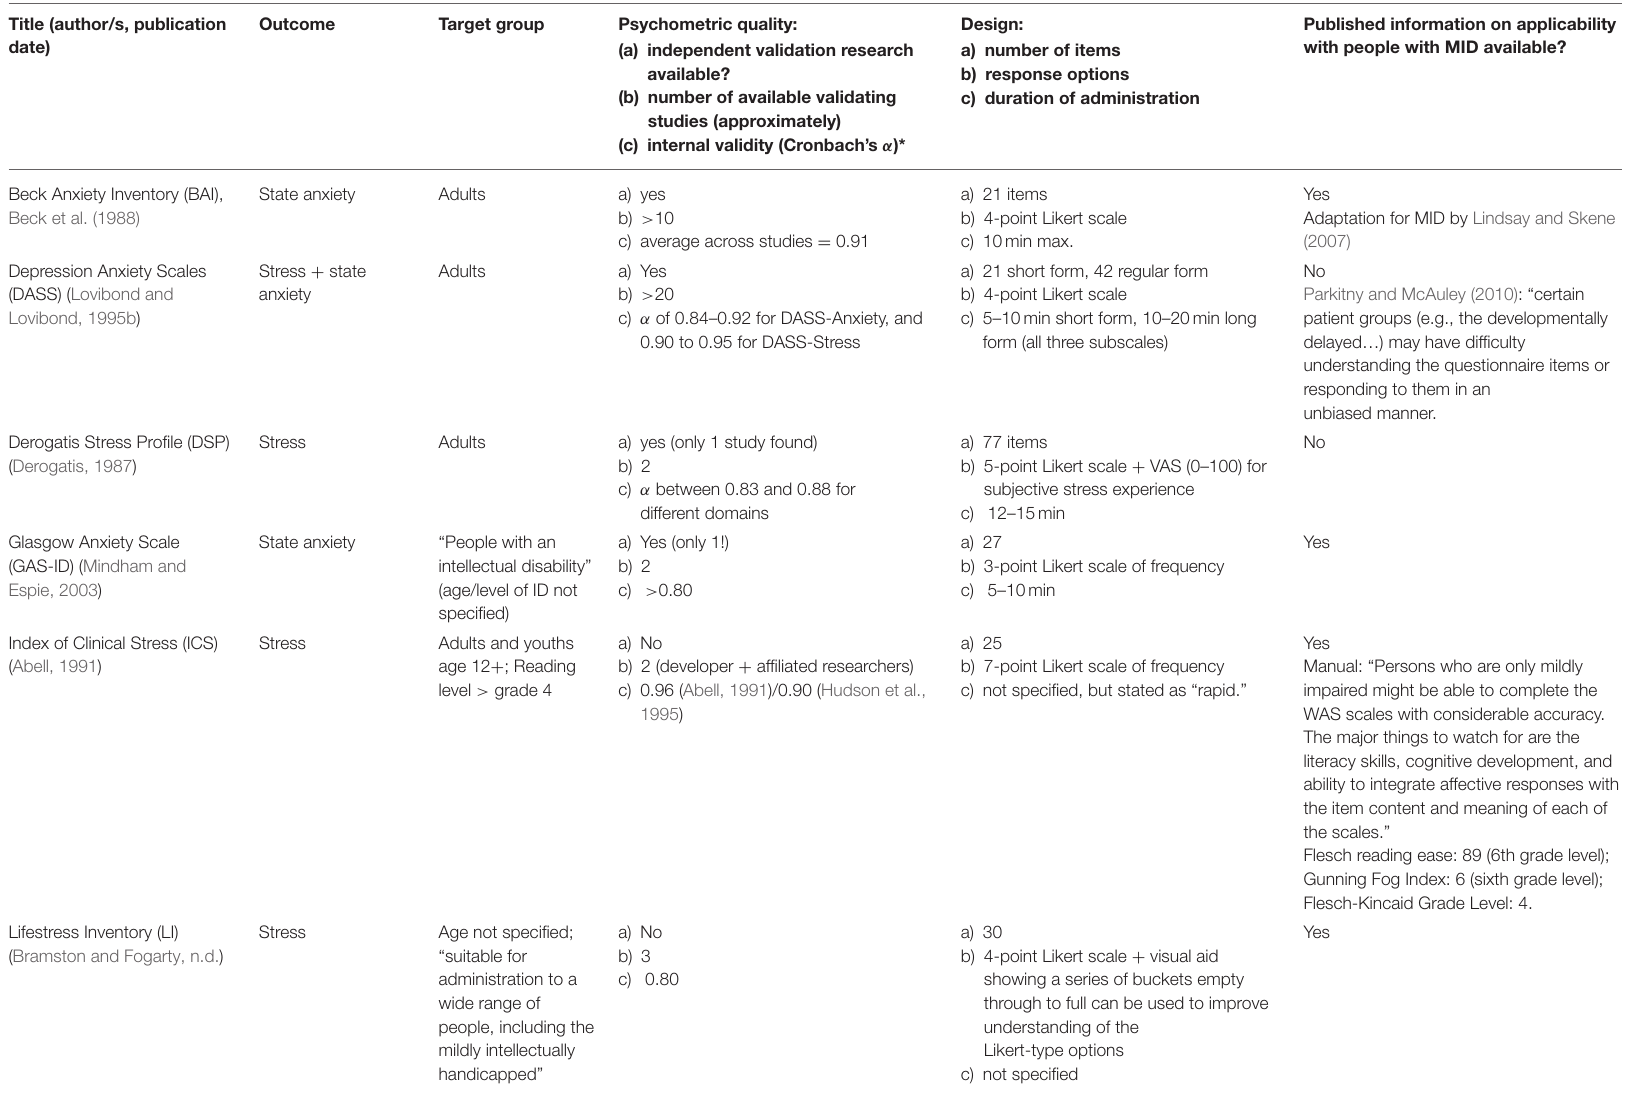
TABLE 2 | Included self-report stress